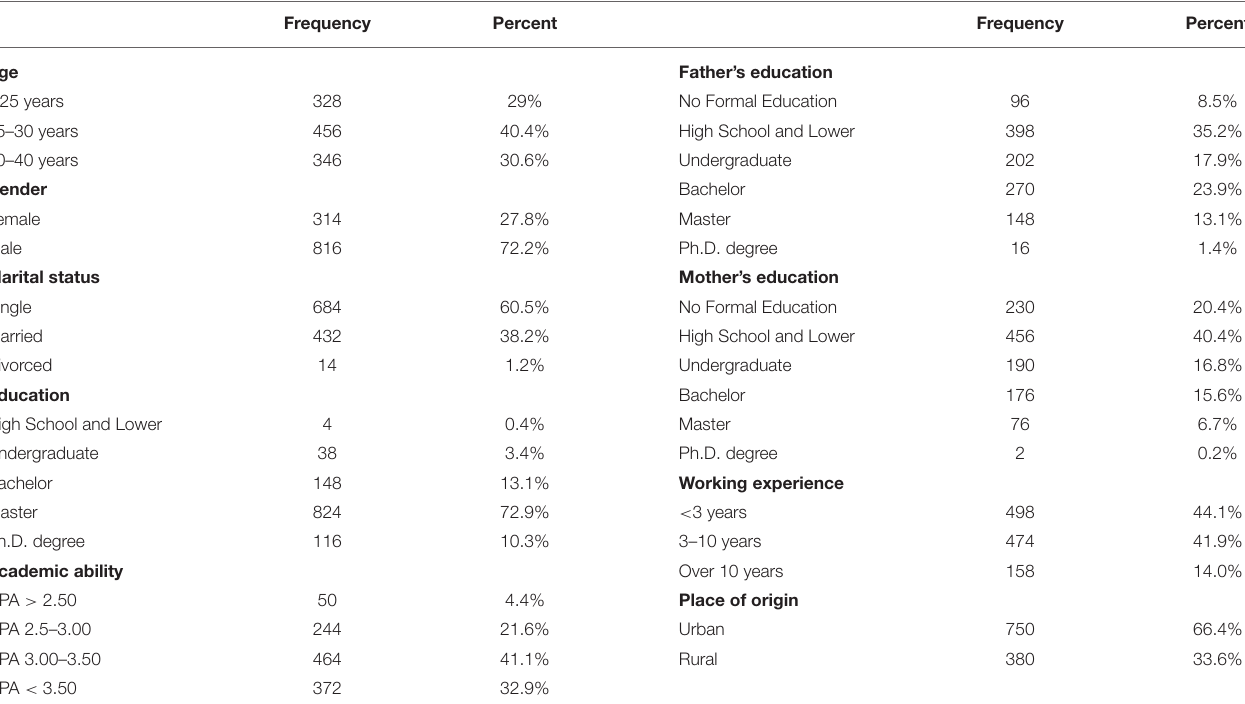
TABLE 1 | Demographic profile of the